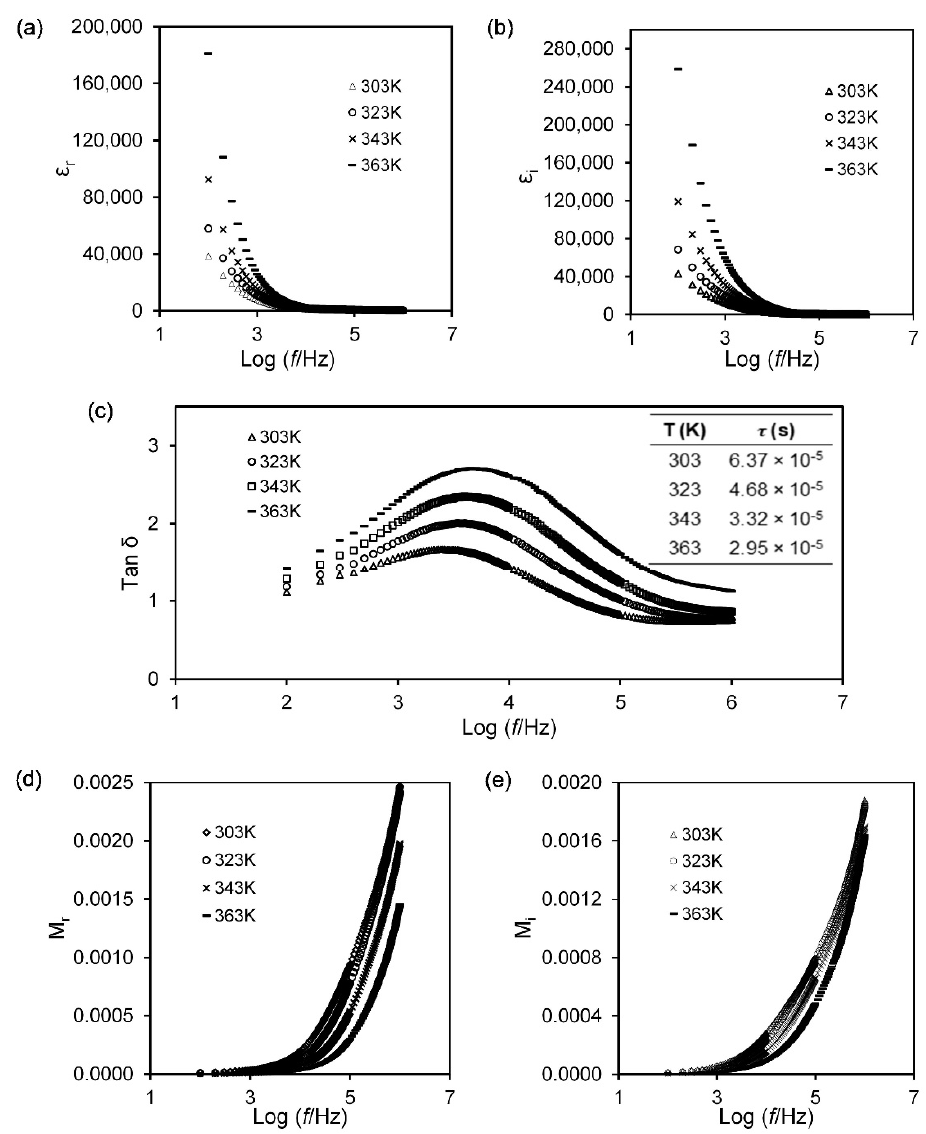
Figure 3. Graph of ( a ) dielectric constant, ( b ) dielectric loss, ( c ) tan δ with table of relaxation value, ( d ) real modulus, ( e ) imaginary modulus as a function of the logarithm of frequency for sample AMg30 at selected temperatures.